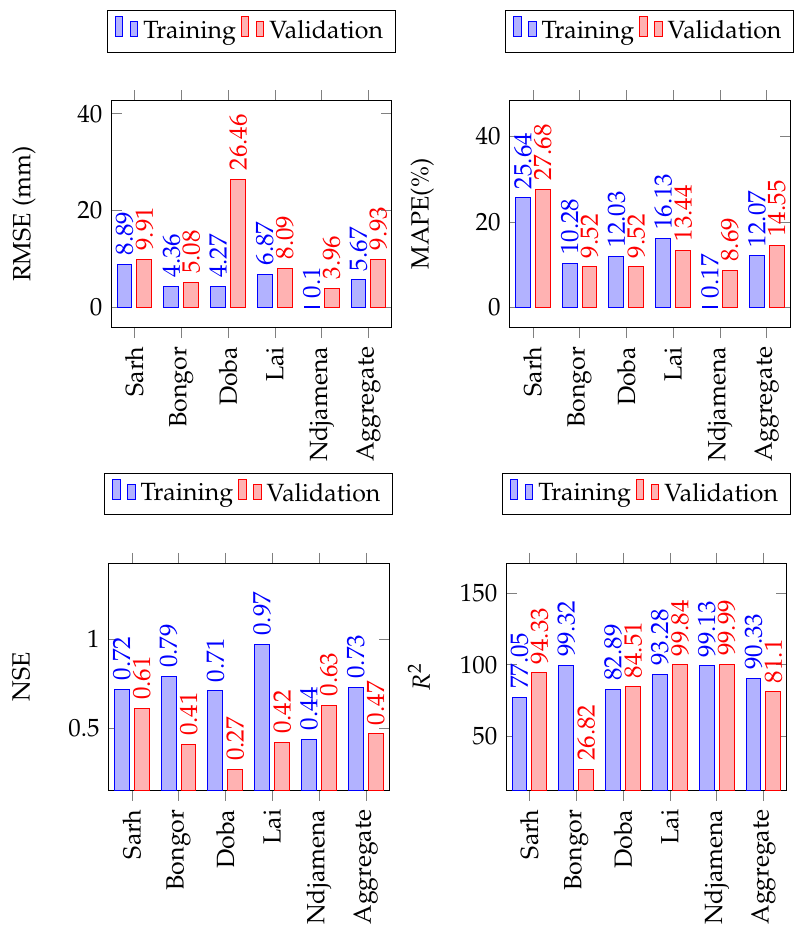
Figure 7. Comparison of SDSM performance on the training and validation sets for monthly maxi- mum temperature forecast in the Lake Chad